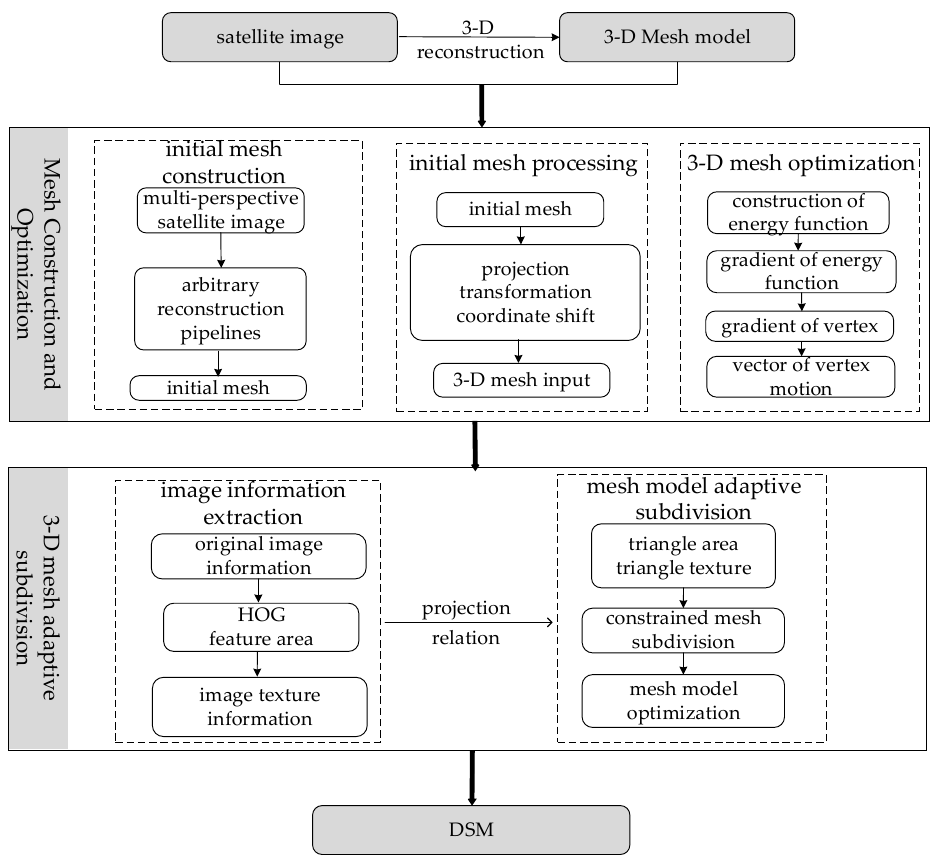
Figure 1. Flow chart of the mesh refinement method.